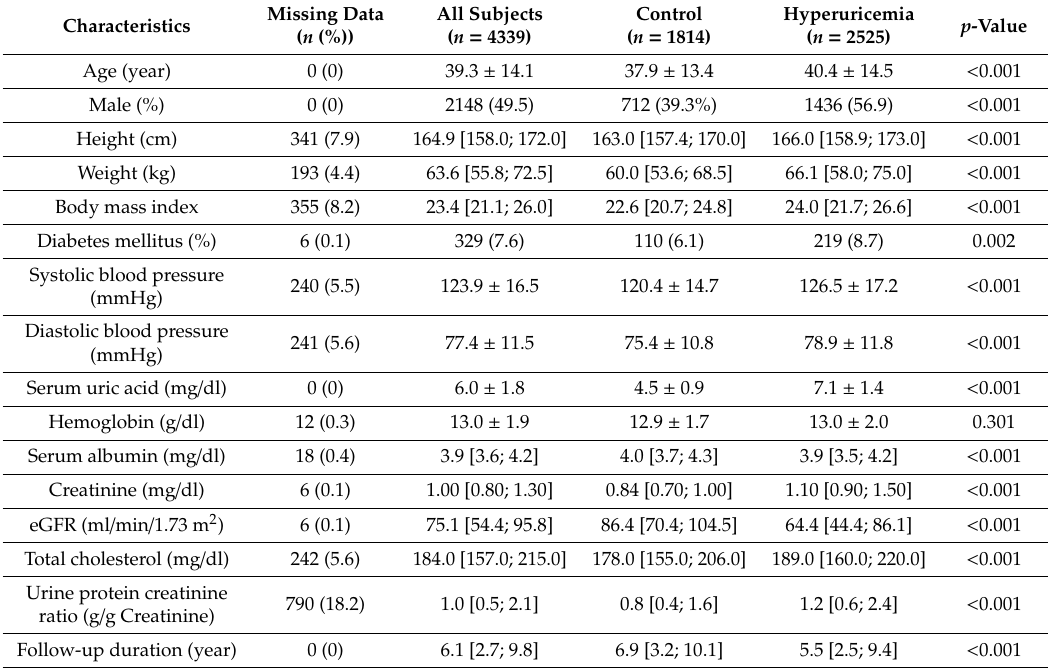
Table 1. Clinical characteristics of the subjects stratified by